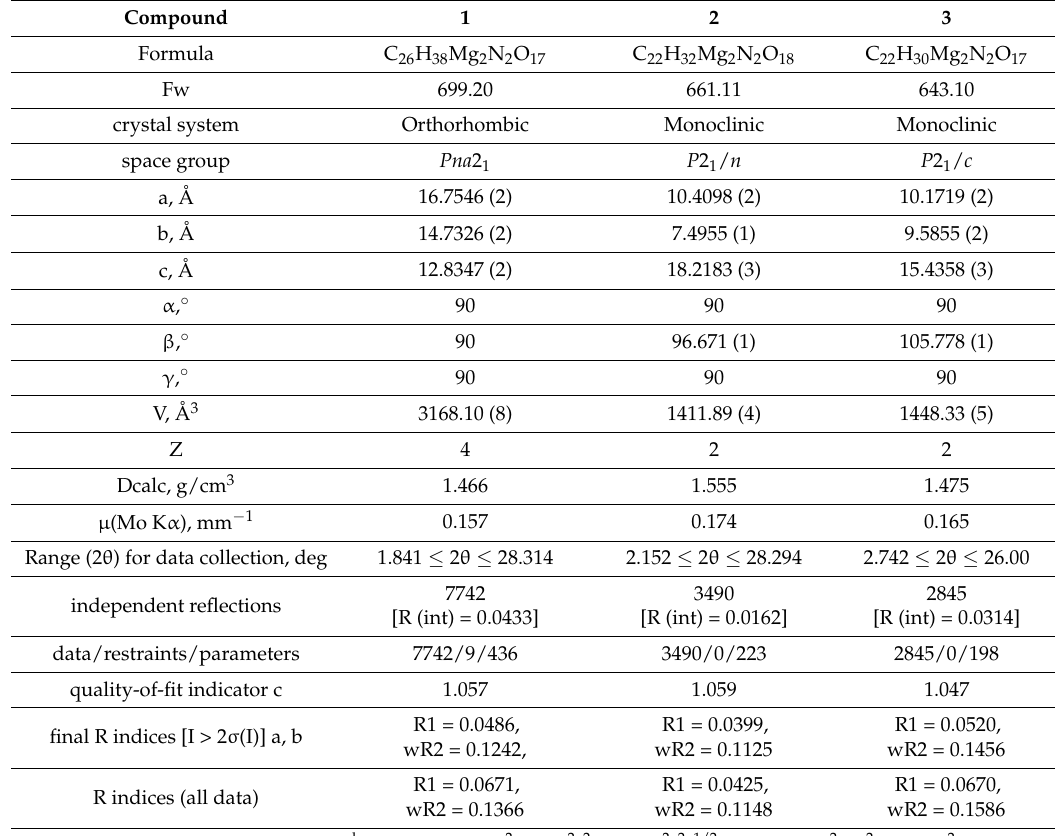
Table 1. Crystal data for Complexes 1 – 3